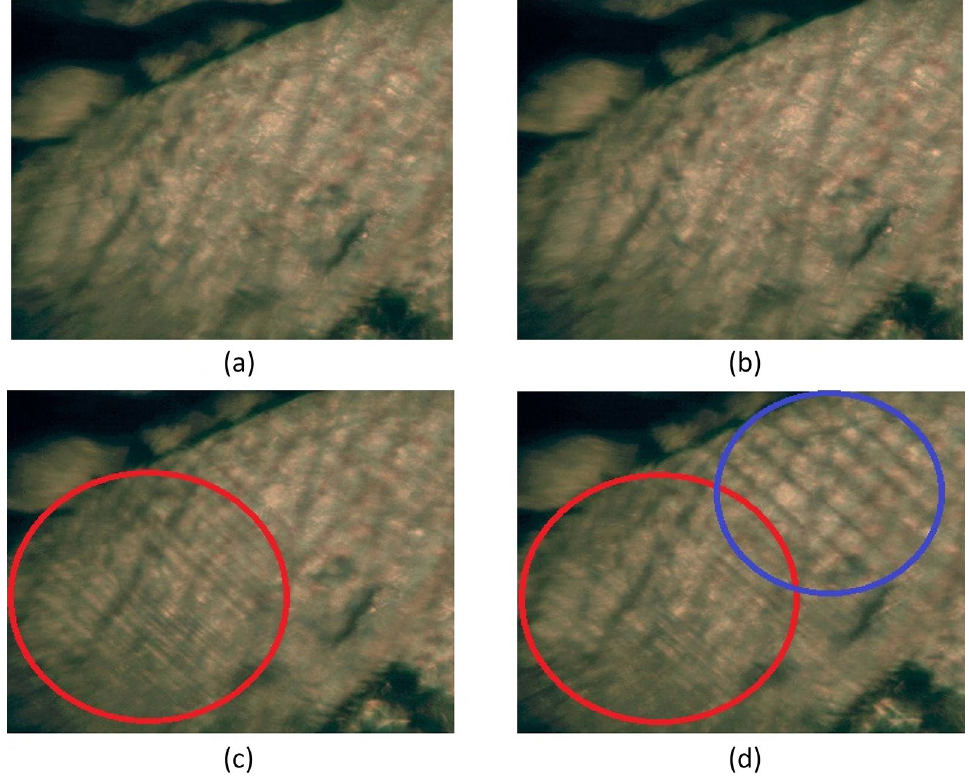
Figure 4. Optical polarizing microscopy images of [NH 3 (CH 2 ) 5 NH 3 ]CdCl 4 at ( a ) phase III (300 K), ( b ) phase II (403 K), ( c ) phase I (420 K), and ( d ) phase I (433 K). The parallel lines represent the ferroelastic twin domain